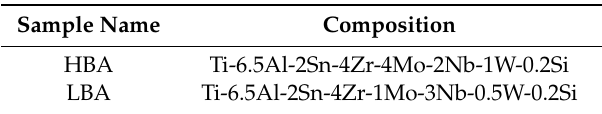
Table 1. Chemical compositions of the alloys (wt.%).